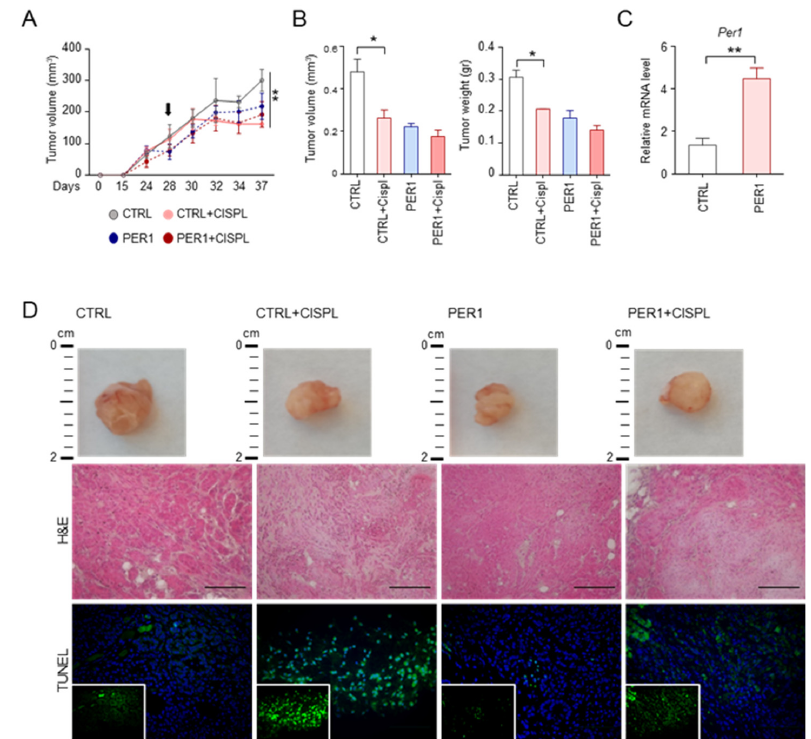
Figure 4. Resistance to treatment in PER1-overexpressing tumors. ( A ) Tumor volume over time of A549-GFP and A549-PER1 subcutaneous tumor xenografts in NSG mice treated with cisplatin. Black arrow: first day of treatment with cisplatin at the concentration of 5 mg/kg, repeated every 3 days for two weeks. Bars represent average ± SEM (n=4 mice). (**) p < 0.01. ( B ) Tumor volume and tumor weight after 15 days of treatment as in (A). Bars represent average ± SEM (n = 4 mice). (*) p < 0.05. ( C ) Control of Per1 level of expression in A549-GFP (CTRL) and A549-PER1 (PER1) subcutaneous tumors, evaluated by qPCR. Bars represent average ± SD (n = 4 mice). ( D ) Representative images of gross histology, histology (H&E staining) and tumor cell death (TUNEL). 40 × magnification (scale bars, 100 µ